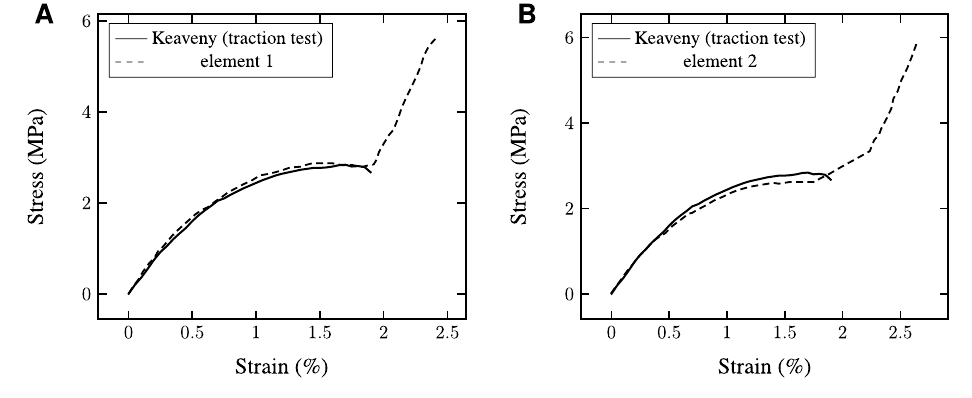
Fig. 9. Results of stress-strain diagrams for element 1 (A) and element 2 (B) - initial